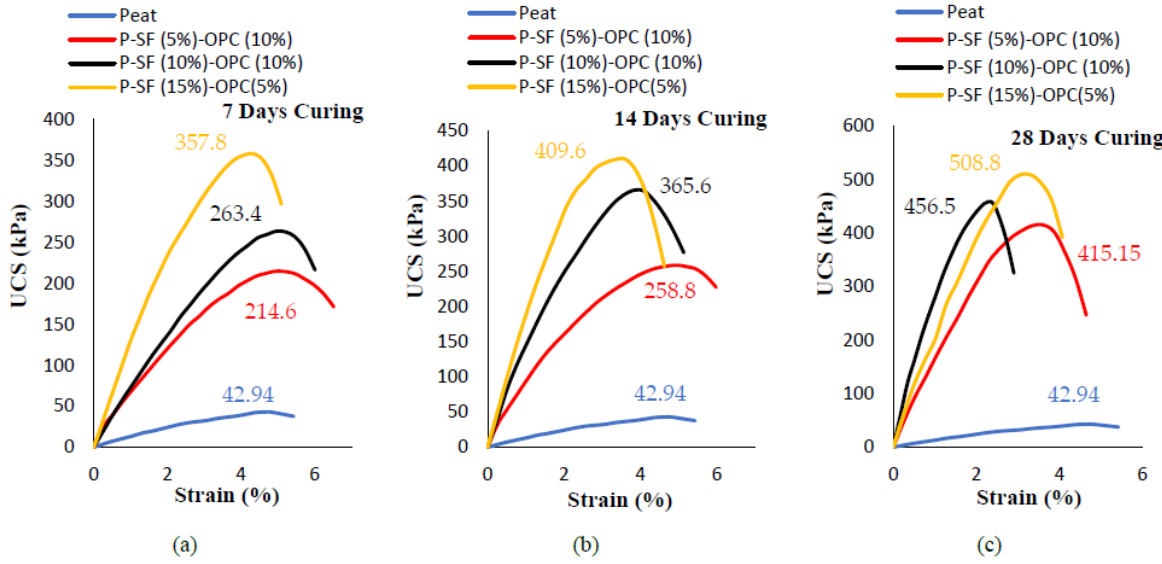
Figure 4. The unconfined compression strength of SF- and OPC-stabilized peat under varying curing periods: ( a ) 7 days, ( b ) 14 days, and ( c ) 28 days.